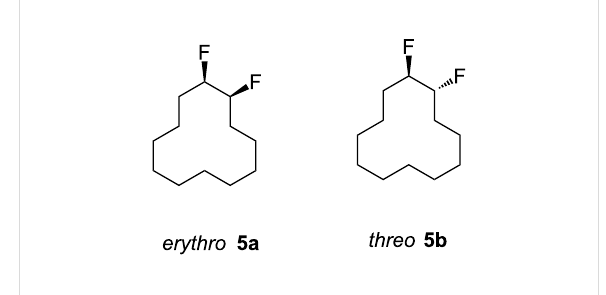
Figure 3: Erythro- and threo -1,2-difluorocyclododecanes ( 5a and 5b